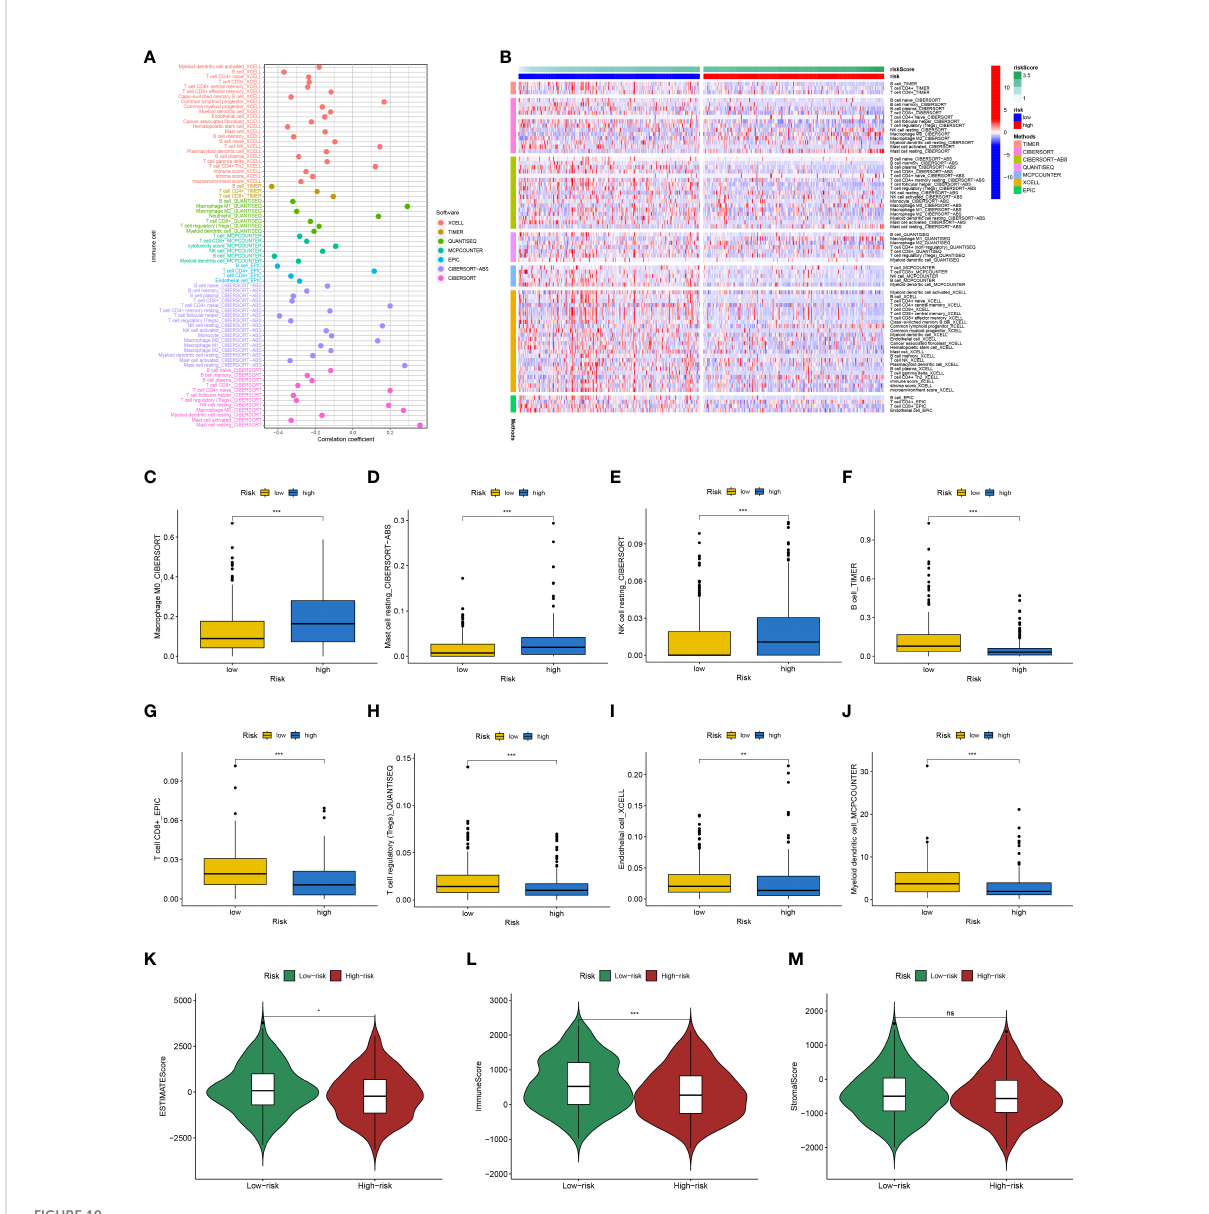
FIGURE 10 Analysis of immune landscape between the high-risk and low-risk groups in the TCGA dataset. (A) Overview of the association among risk scores and immune cells and stromal cells shown by Spearman correlation analysis. (B) Overview of immune cell differences between the two groups. The higher risk score was positively associated with the presence of tumor-in fi ltrating immune cells, including M0 macrophages (C) , resting mast cells (D) , and resting NK cells (E) , as well as was negatively associated with the presence of B cells (F) , CD8 + T cells (G) , regulatory T cells (H) , endothelial cells (I) , and myeloid dendritic cells (J) . Differences in estimate Score (K) , immune Score (L) , and stromal Score (M) from ESTIMATE algorithms between two groups. (*p<0.05; **p<0.01; ***p<0.001; ns, no signi fi